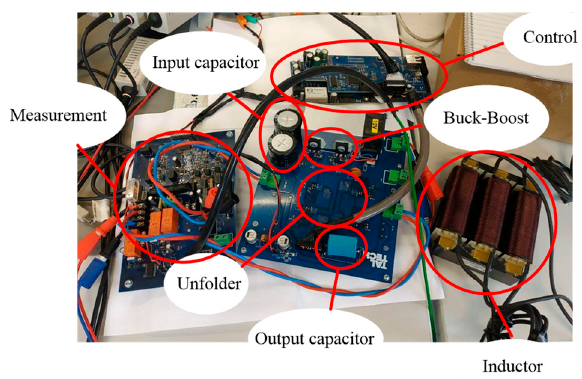
Figure 9. Experimental setup of the twisted buck boost converter with unfolding circuit.